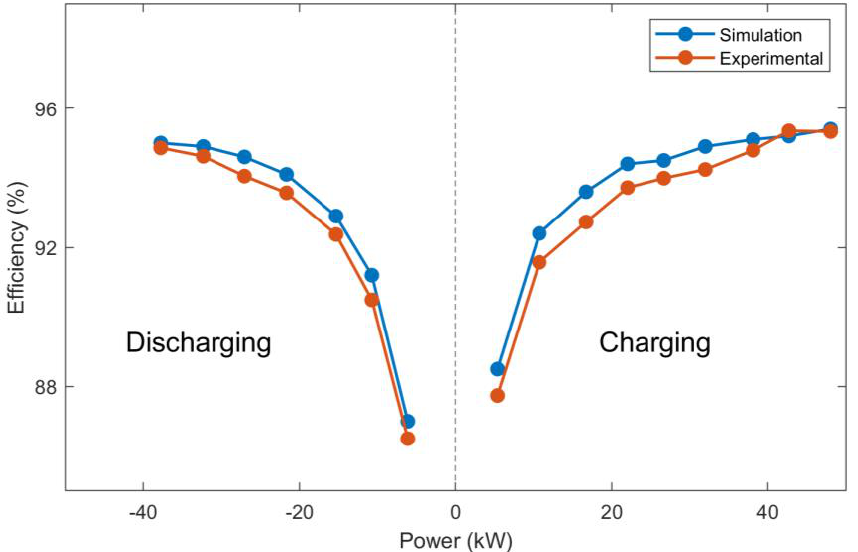
Figure 4. Efficiency comparison between the simulated electro-thermal model and the experimental measurements on the charging system.